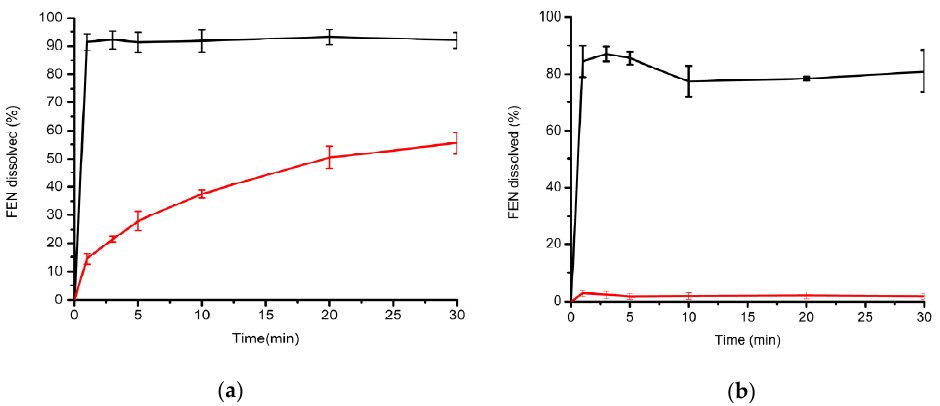
Figure 4. Comparative in vitro dissolution studies carried out in two different dissolution media: ( a ) 0.025 M aqueous SDS and ( b ) water. Black trace: electrospun FEN-loaded microfibers; red trace: micronized API.